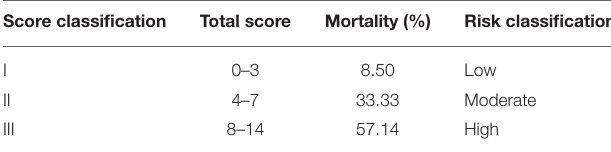
TABLE 5 | Three risk classification of the predictive score